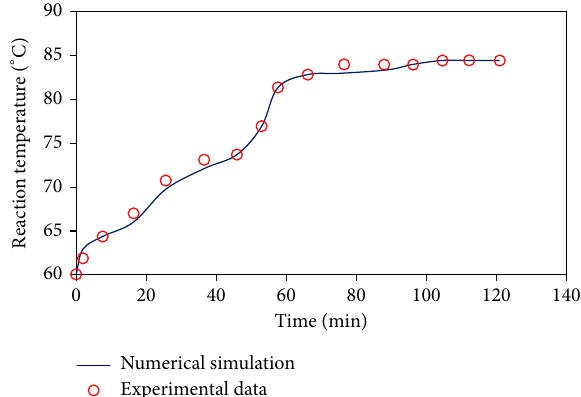
Figure 7: Comparison of the reaction temperature predicted by the model and the laboratory measurements.